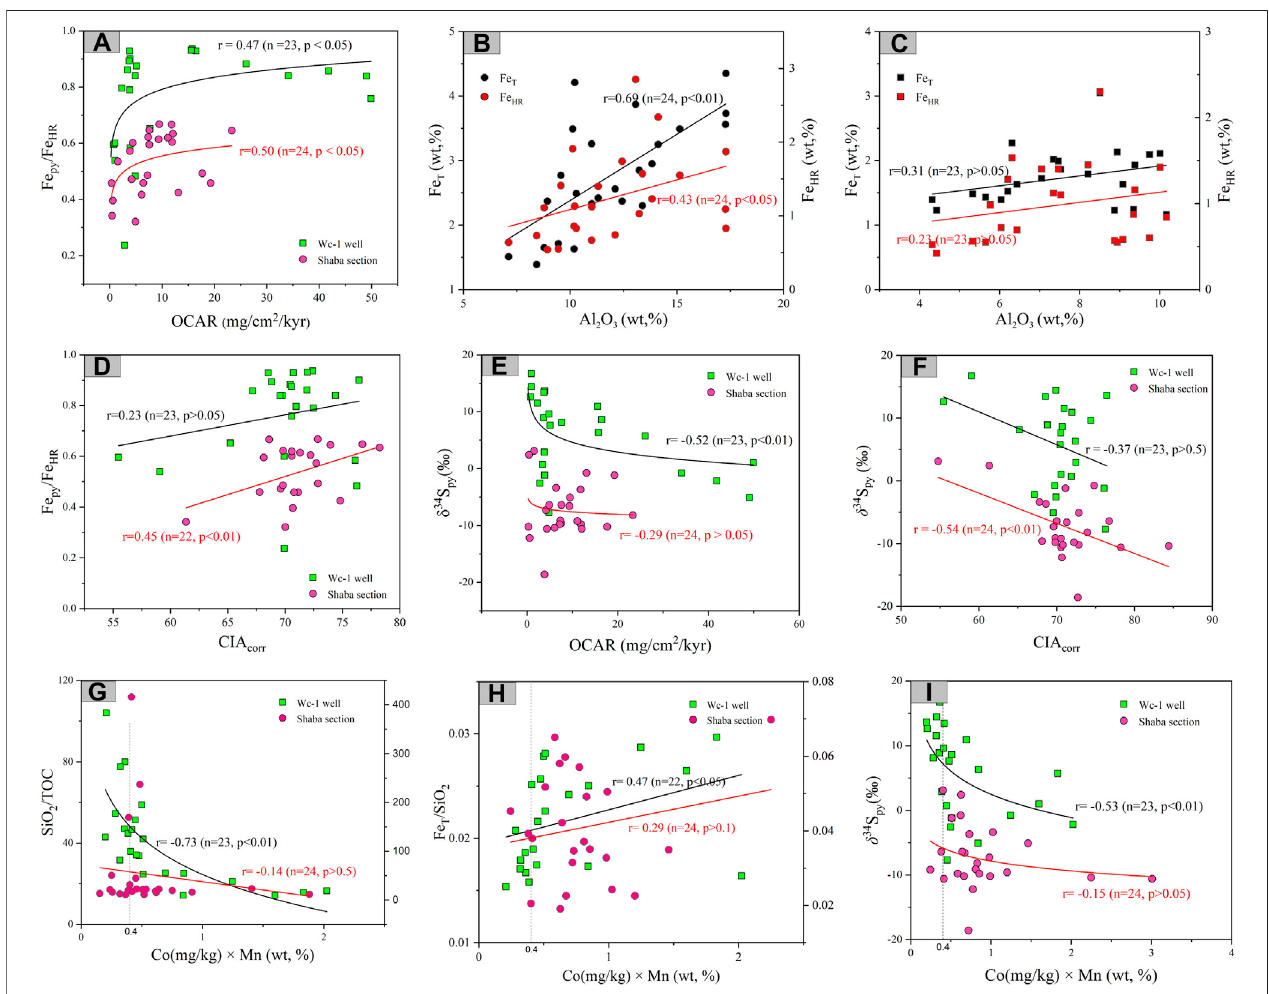
FIGURE 8 | Relationship between research area elements. (A) Logarithmic relationships between OCAR with Fe py /Fe HR . (B) Al 2 O 3 verses Fe T for Shaba section. (C) Al 2 O 3 versesFe T forWc-1well. (D) CIA corr versesFe py /Fe HR . (E) LogarithmicrelationshipbetweenOCAR with δ 34 S py . (F) CIA corr verses δ 34 S py . (G) CrossplotsofCo × Mn versus SiO × Mn versus Fe × Mn with δ 34 S 2 /TOC. (H) Cross plots of Co T /SiO 2 . (I) Logarithmic relationships between Co py